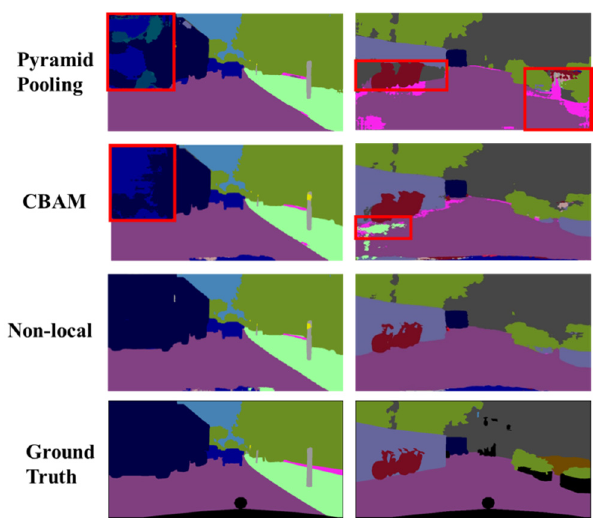
Figure 8. Visualization results on Cityscapes val. set of applying di ff erent methods in the global module.